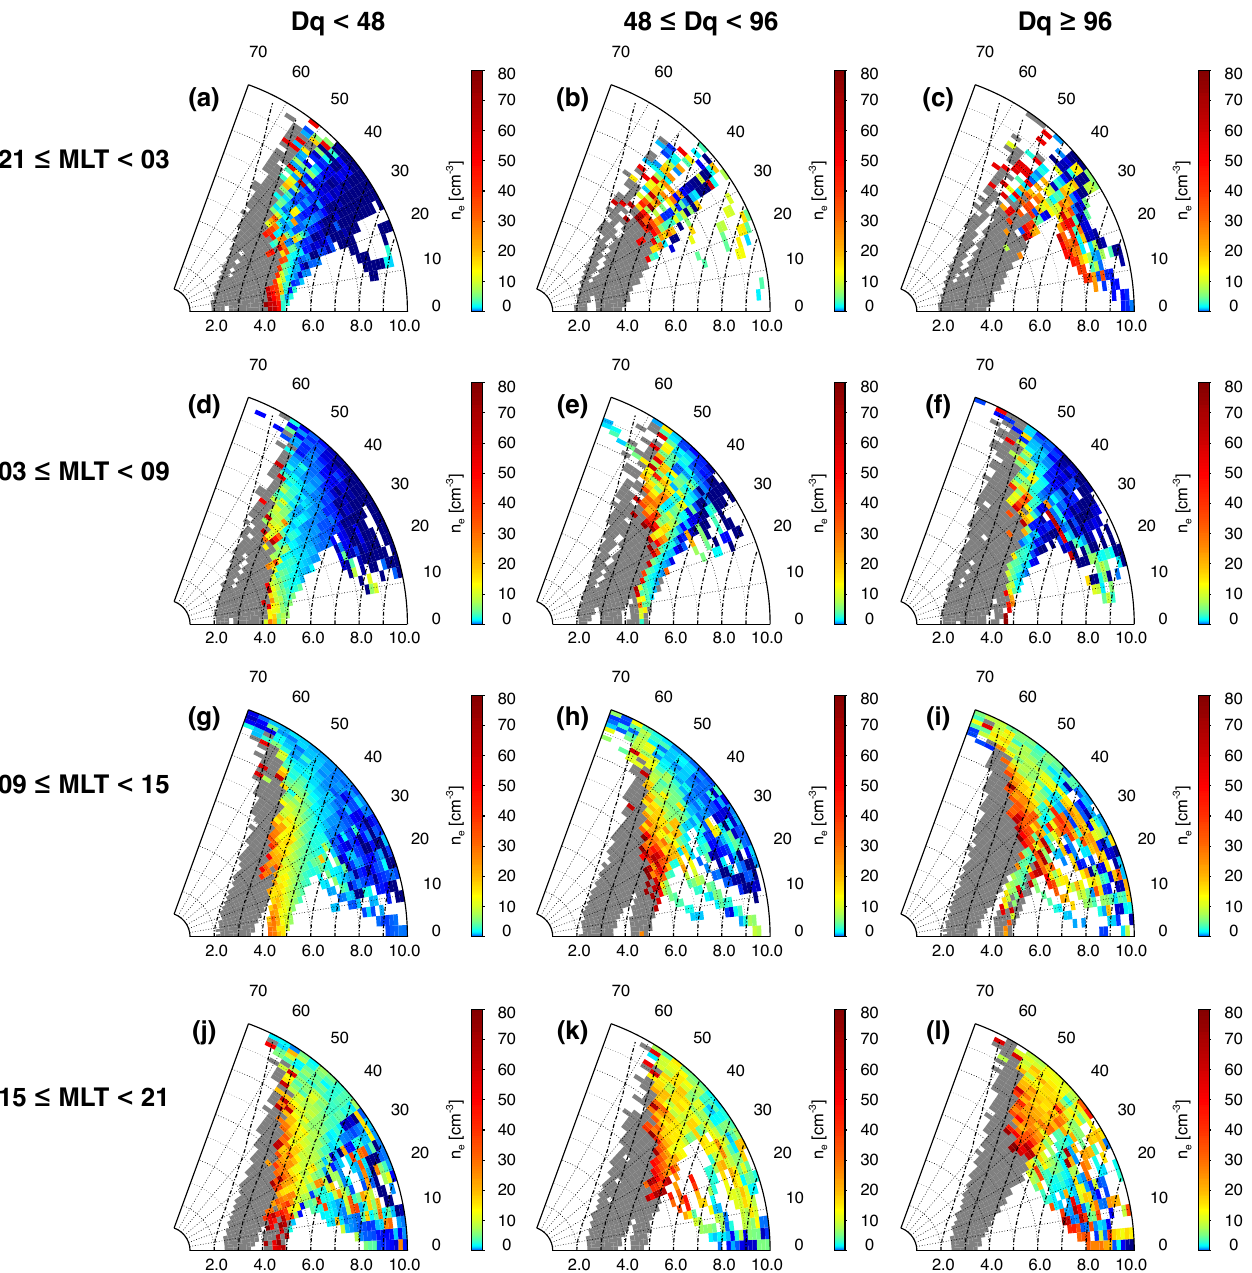
Fig. 6. L -MLat views of the median value of densities measured at a given L -shell and magnetic latitude (defined in absolute value) using a resolution of 0.2 in L and 2 . 8 ◦ in MLat. Datasets combine density records over large local time sectors, 21:00–03:00MLT (first row), 03:00–09:00MLT (second row), 09:00–15:00MLT (third row) and 15:00–21:00MLT (fourth row). The three columns are defined as in Fig. 5. Colour codes are defined as in Fig. 5, second row. Iso- R curves, where R is the geocentric distance derived from the L -MLat position, according to the dipolar model, are also superimposed (dashed-dot lines) in order to guide the